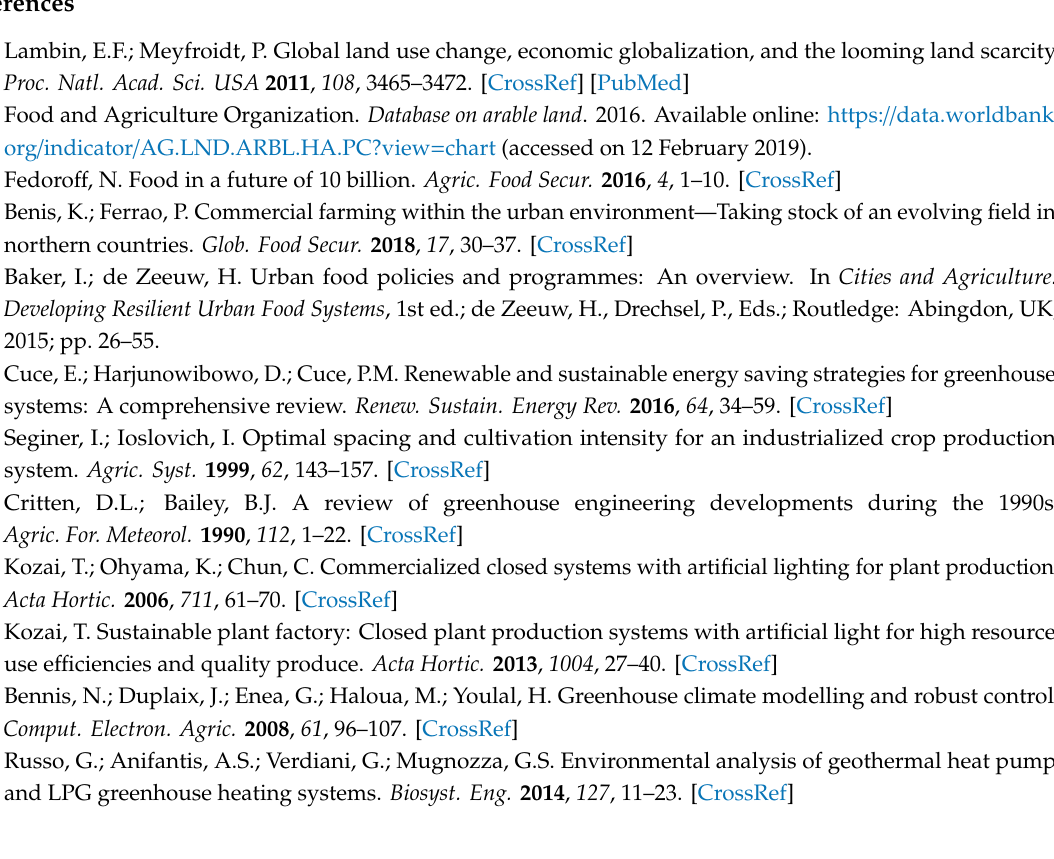
Table S1. Decline in arable land (hectares per person) from 1961 to 2015. Table S2. Comparison of potential yield between greenhouse and field grown